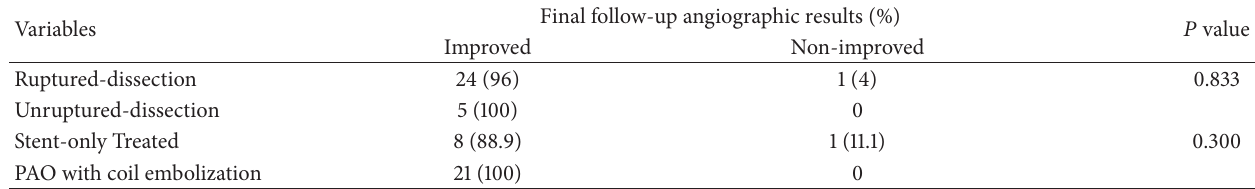
Table 2: Follow-up angiographic results according to presentation and endovascular therapeutic